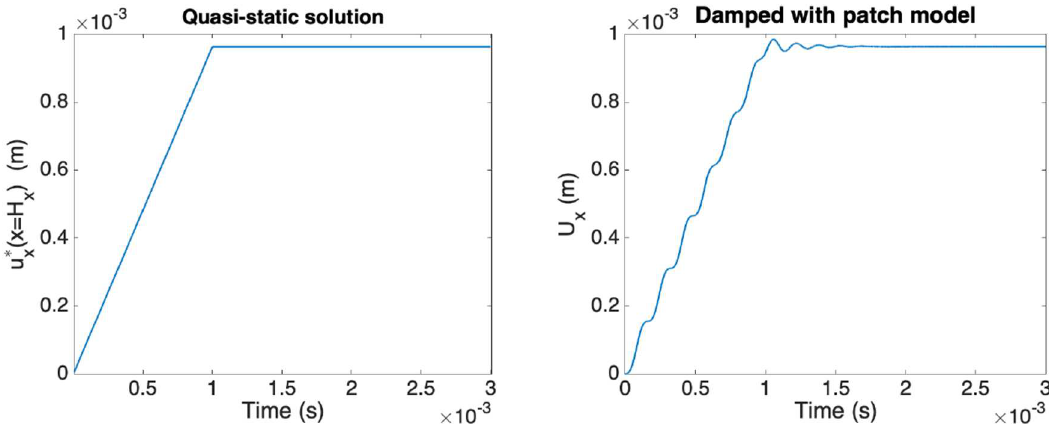
Fig. 15. Quasi-static solution given in Figure 9 (left) versus the explicit damped obtained using the global-local integration schema (right).